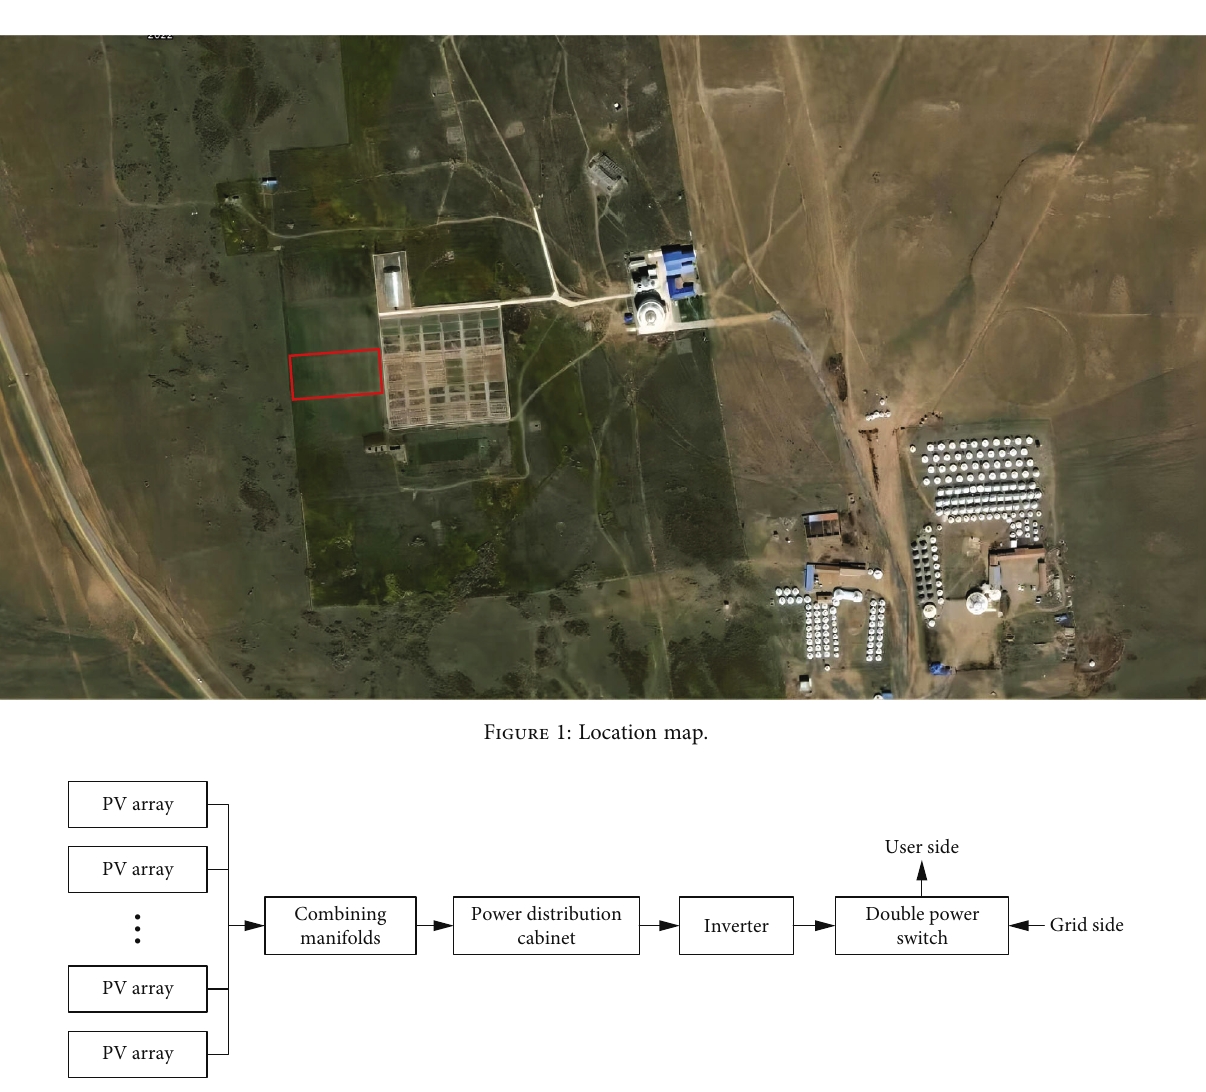
Figure 2: Schematic diagram of the PV power generation system.